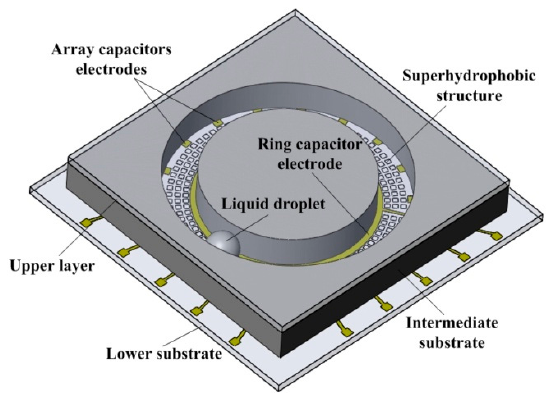
Figure 1. A schematic diagram of the microelectromechanical system (MEMS) liquid droplet inclinometer sensor structure.